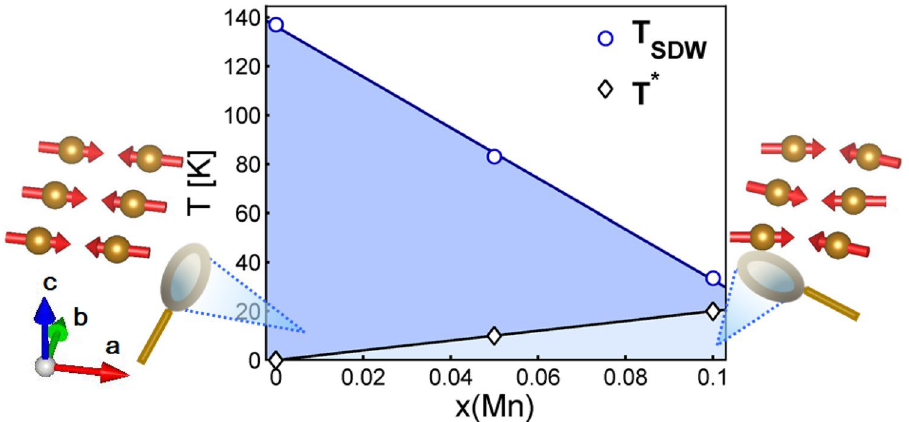
Figure 6. Phase diagram of SmFe 1 − x Mn x AsO, showing the commensurate ordered phase (dark-blue area) and the Mn-induced incommensurate ordered phase (light-blue area). The collinear vs. tilted arrangement of Fe moments is also sketched. Data for x = 0 are from Ref.